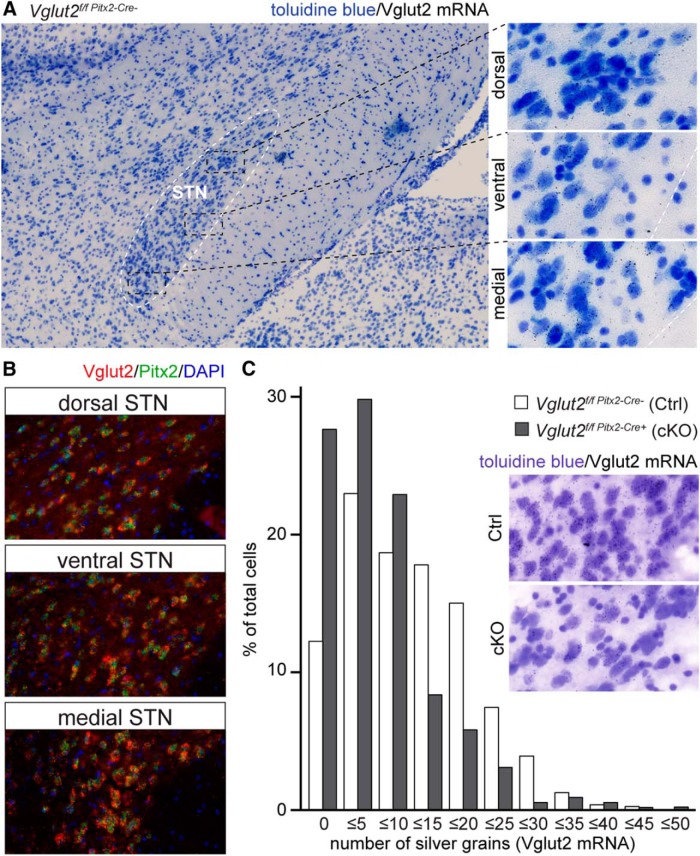
Strong overlap of Vglut2 and Pitx2 in the STN and reduction of Vglut2 mRNA in cKO mice. A, Representative examples of cell morphology and distribution. Overview of the STN (left) as well as close-up images of the dorsal (right top), ventral (right center), and medial (right bottom). Cells are stained blue; small dots represent silver grains bound to Vglut2 mRNA. B, Double fluorescent in situ hybridization for Vglut2 (red) and Pitx2 (green) as well as nuclear stain with DAPI (blue) in the dorsal (top), ventral (center), and medial (bottom) STN. C, High-resolution in situ hybridization analysis of Vglut2 mRNA-based silver grain intensity shows a generally lowered expression of Vglut2 in the STN of cKO mice.